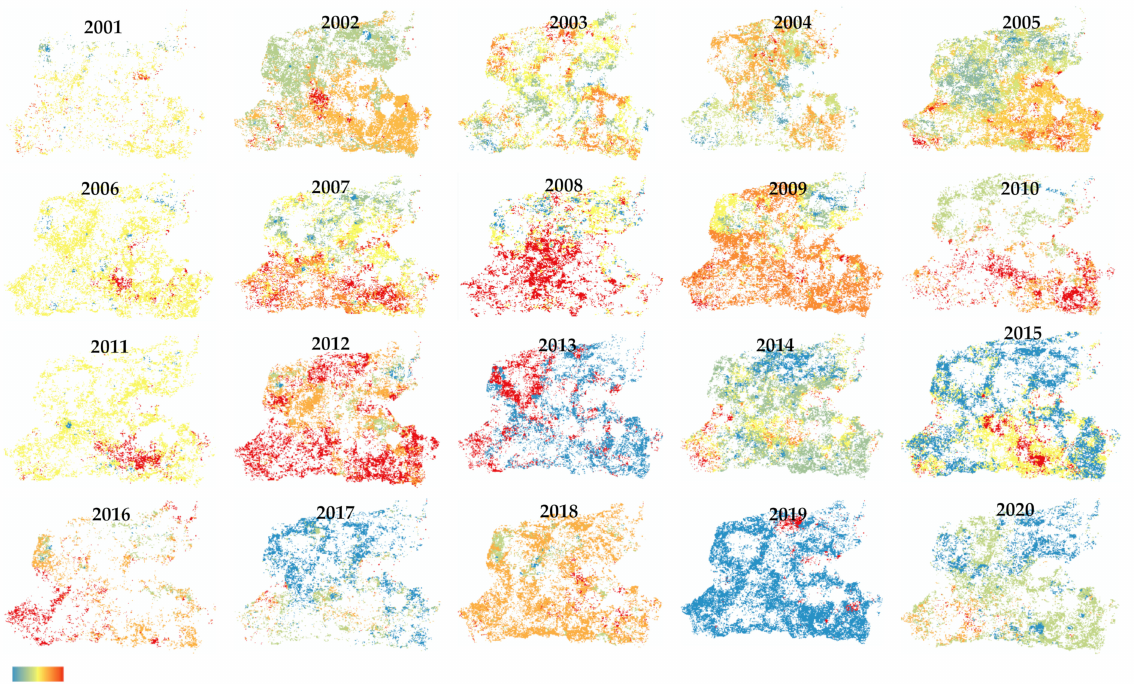
Figure 6. Trends and patterns of water deficiency duration in the Brantas watershed 2001–2020. Blue: 1 month–Red: 12